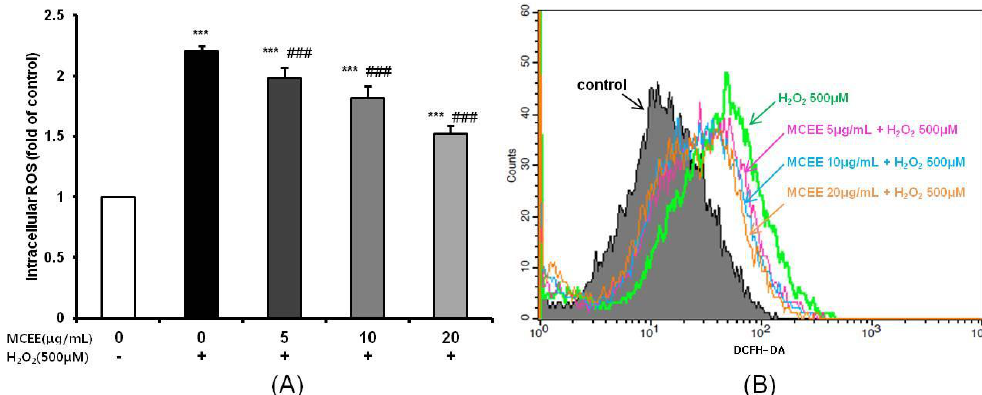
Figure 2. The inhibitory effects of MCEE on H 2 O 2 -induced intracellular reactive oxygen species (ROS) production in SK-N-MC cells. The intracellular ROS production was determined by the DCFH-DA method using a fluorescence microplate reader ( A ) and flow cytometry ( B ). The SK-N-MC cells were incubated with MCEE for 24 h, then treated with H 2 O 2 for 1 h. The results are expressed as the means ± S.D. ( n = 3). *** p < 0.001 compared with the untreated control cells, ### p < 0.001 compared with only H 2 O 2 -treated cells.